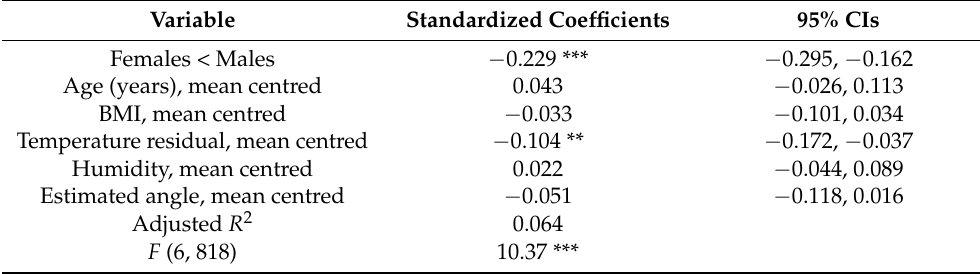
Table 2. Summary of the effects of individual differences and climate variables on vertical speed of stair climbing (m · s − 1 ). Variable Standardized Coefficients 95%